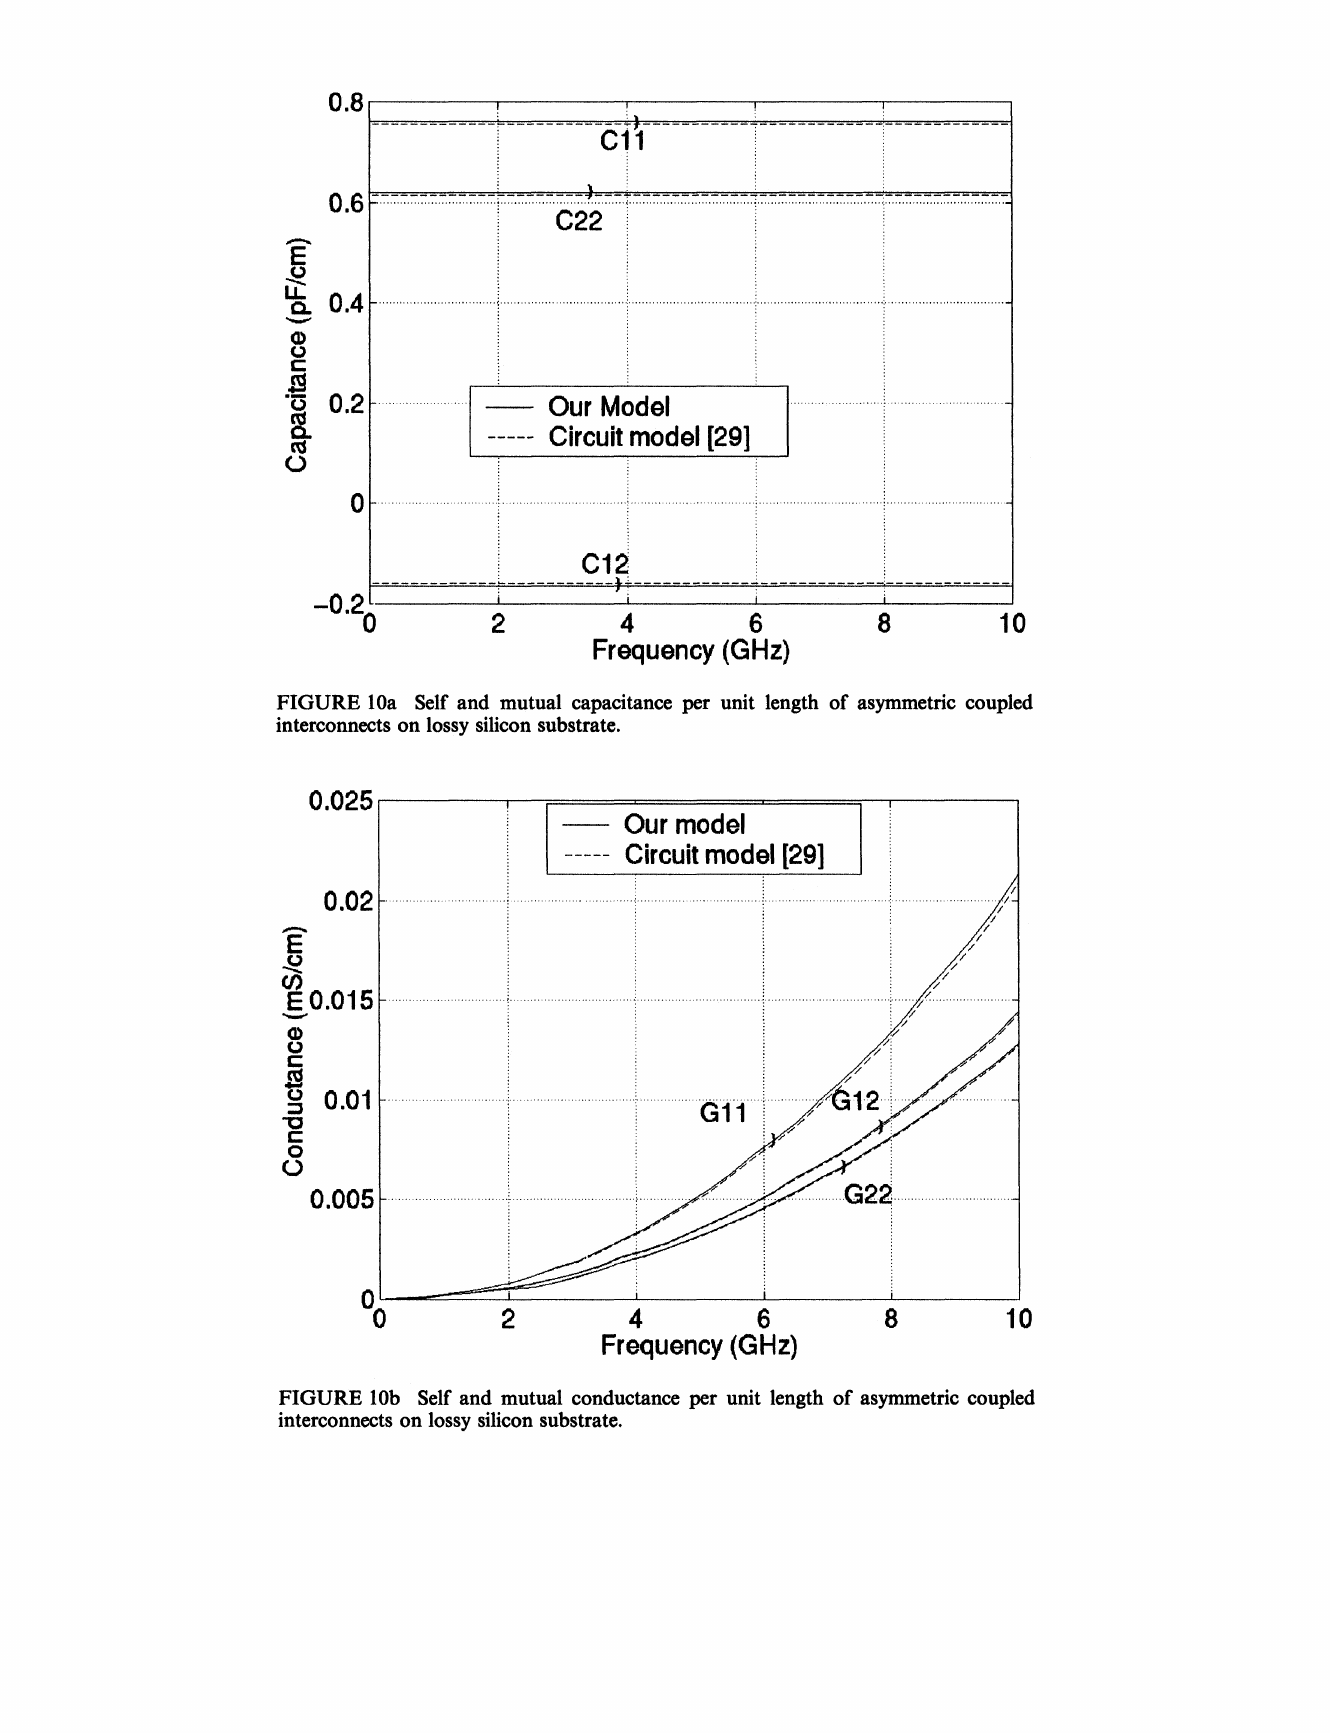
FIGURE 10b Self and mutual conductance per unit length of asymmetric coupled interconnects on lossy silicon